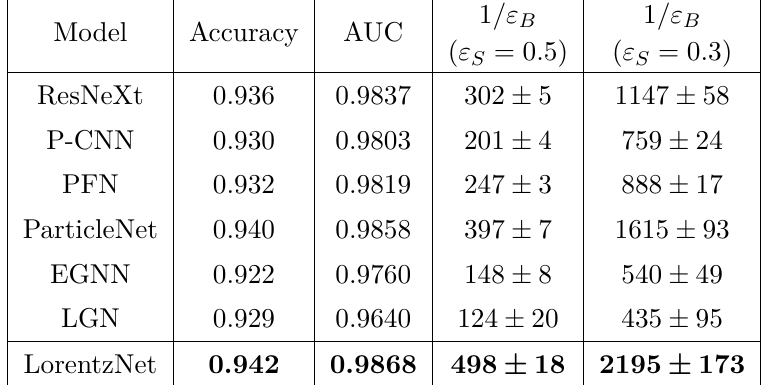
Table 1 . Performance comparison between LorentzNet and other representative algorithms on top tagging dataset. The results for LorentzNet and EGNN are averaged on 6 runs. The results for other baselines are referred to [36, 37, 61].